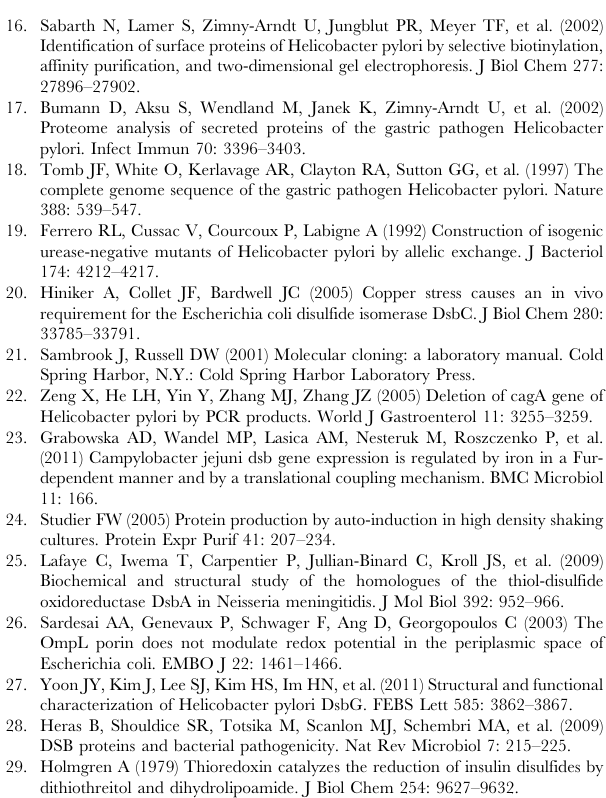
Figure S1 Confirmation of hp0231 mutation by Western- blot analysis. H. pylori wt N6 and N6 hp0231 :: cat proteins (the whole cell lysate) were separated by 12% SDS-PAGE and electrotransfered onto a nitrocellulose membrane. Specific rabbit serum with antibodies against HP0231 were used to verify the lack of HP0231 in N6 hp0231 :: cat mutant cells. The asterisks denote unknown proteins recognized by the antiserum. The relative positions of the molecular weight markers (lanes M) are listed on the left (in kilodaltons). (TIF)